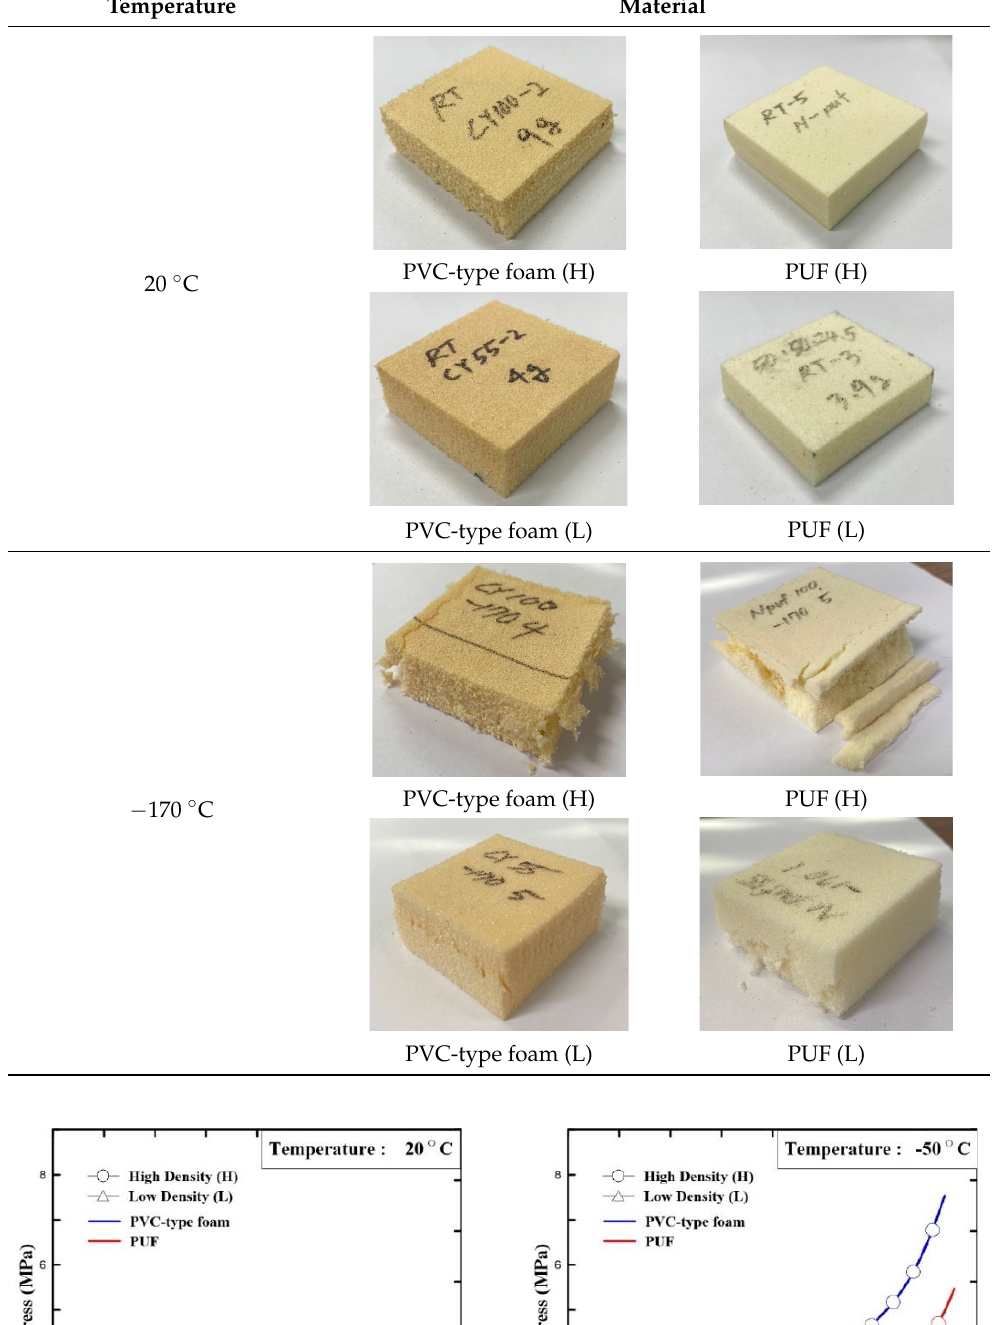
Table 6. Photographs of specimens after the compressive test.